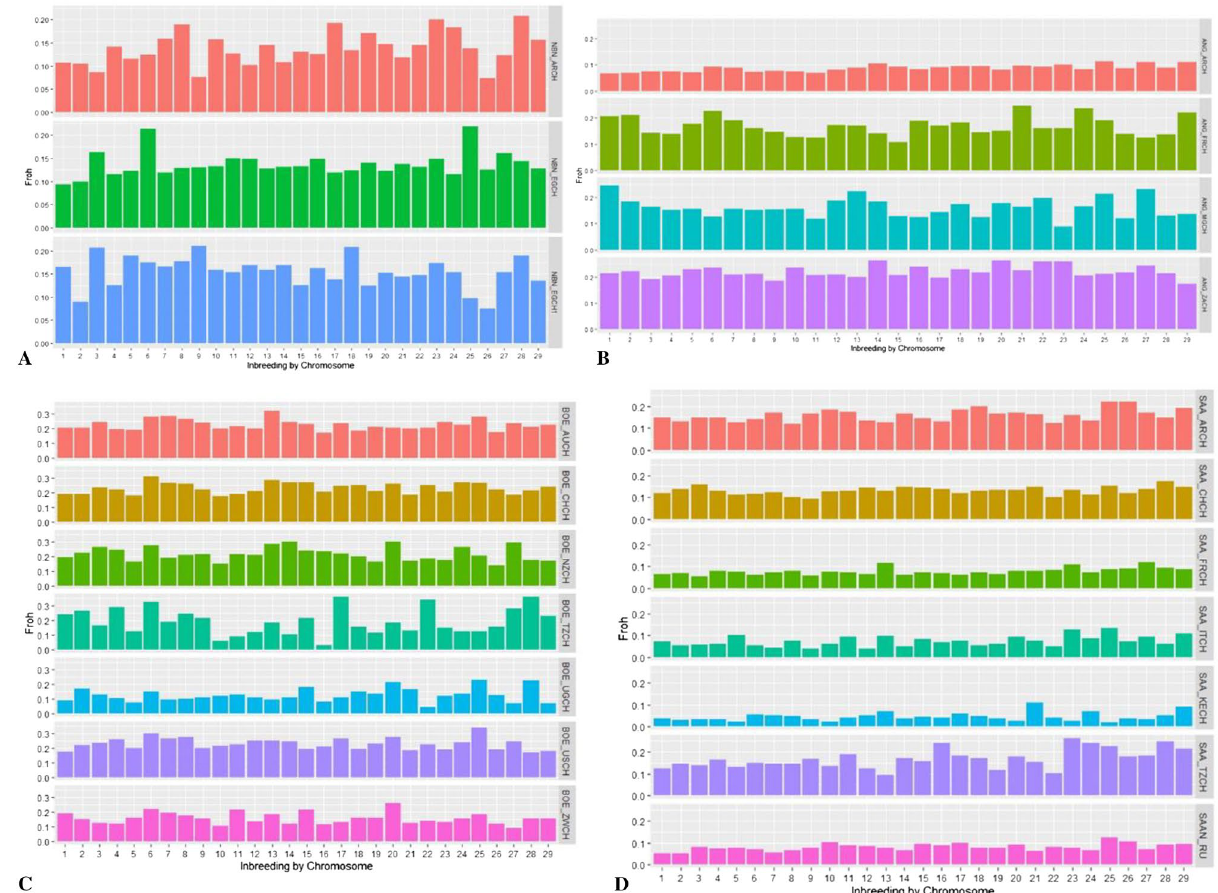
Figure 4. Distribution of genomic inbreeding coefficient (FROH) or ROH-based inbreeding per chromosome and for each breed. Every bar represents a chromosome and a different colour is associated with a population for every breed. A = Nubian, B = Angora, C = Boer and D =